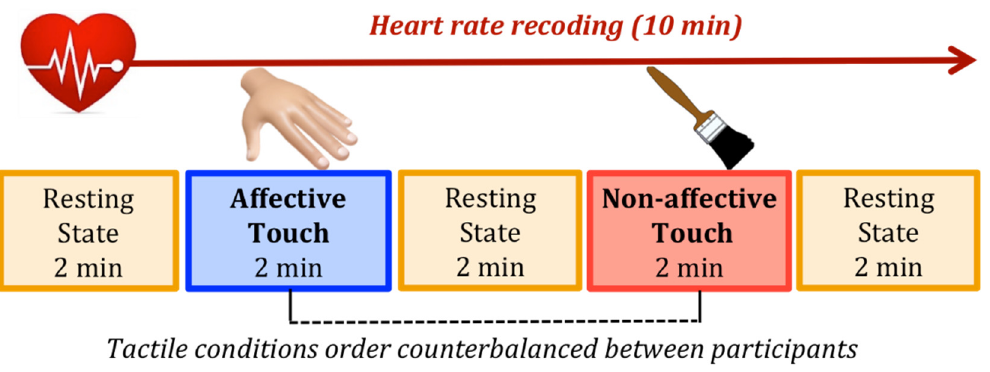
Figure 1. Example of experimental session: newborns’ heart rate was recorded for 10 min, alternating 2 min of resting with 2 min of tactile stimulation (affective touch vs. non-affective touch) in counterbalance order between participants .